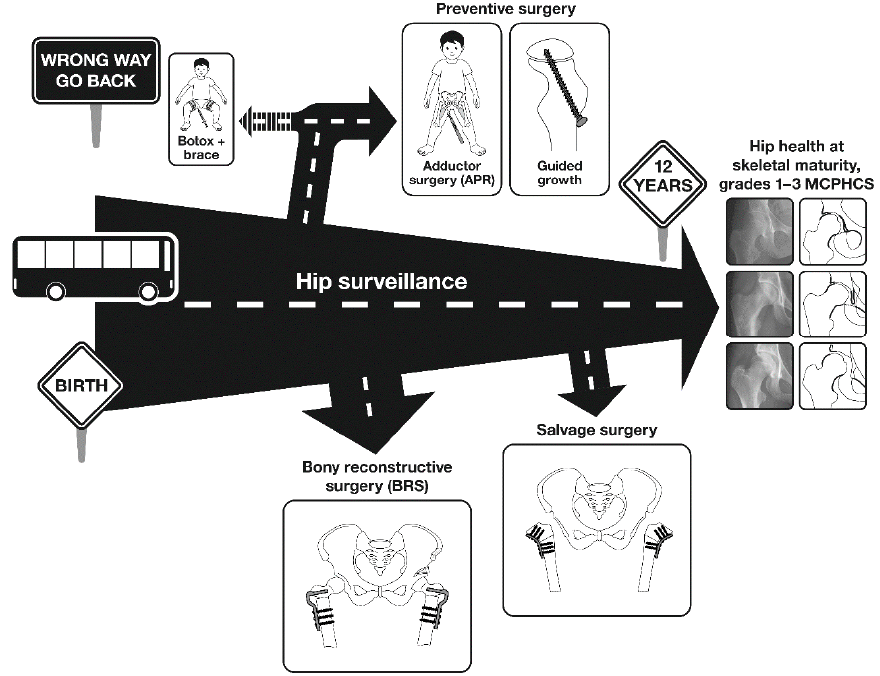
Figure 3. The hip surveillance journey. Copyright Bill Reid, Pam Thomason and Kerr Graham, RCH Melbourne.